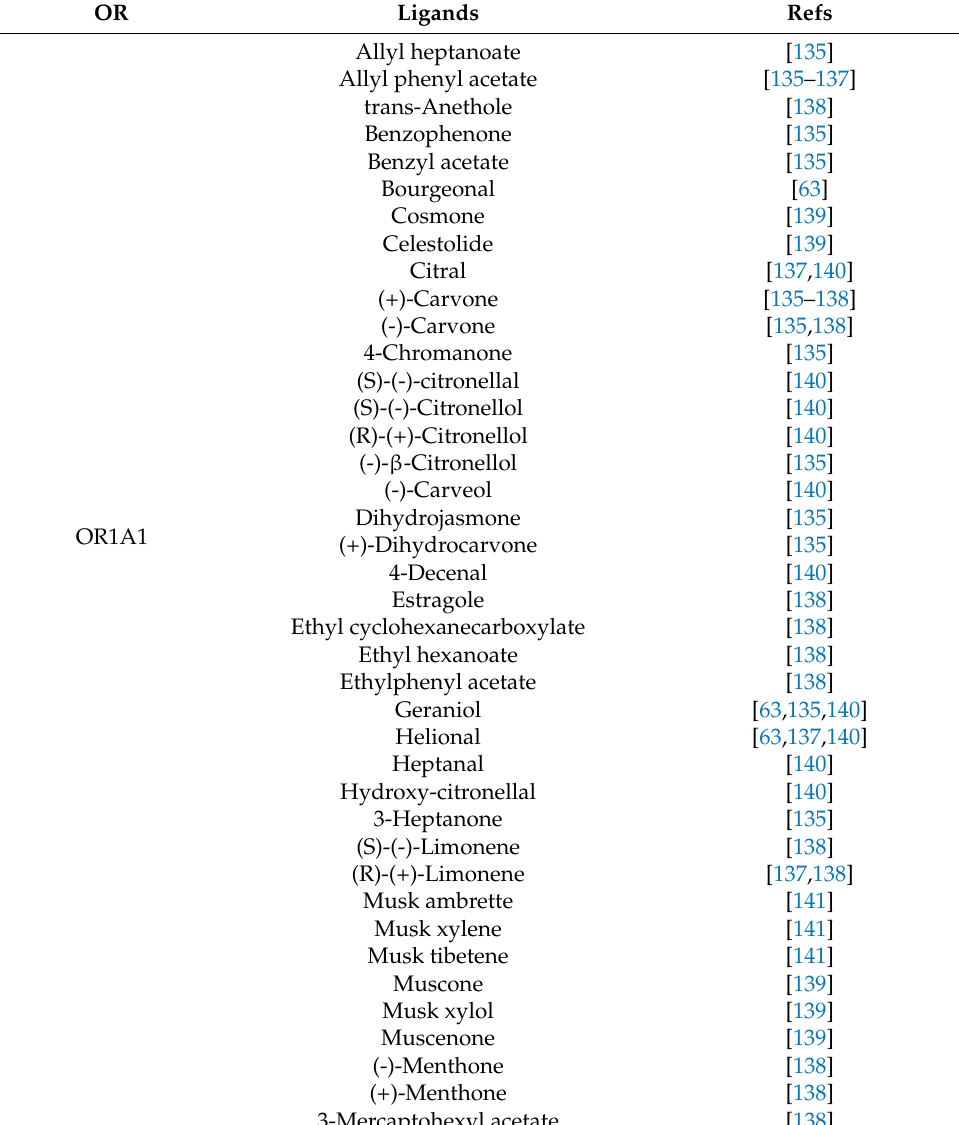
Table 1. An excerpt of deorphanized human ORs with corresponding odorant compounds, data from